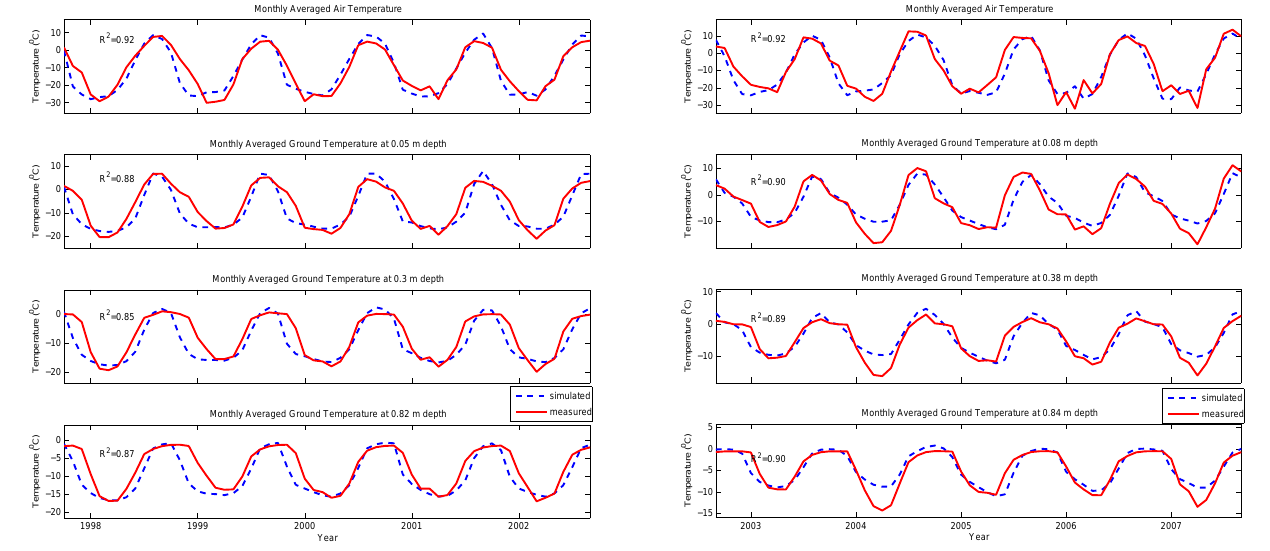
Fig. 4. Measured (solid) and calculated (dashed) monthly averaged temperatures at the amount of saturated water coefficient 2m above the ground and 0.08, 0.38 and 0.84m depth for Galbraith Lake 68.48 ◦ N, − 149.50 ◦ W permafrost observation